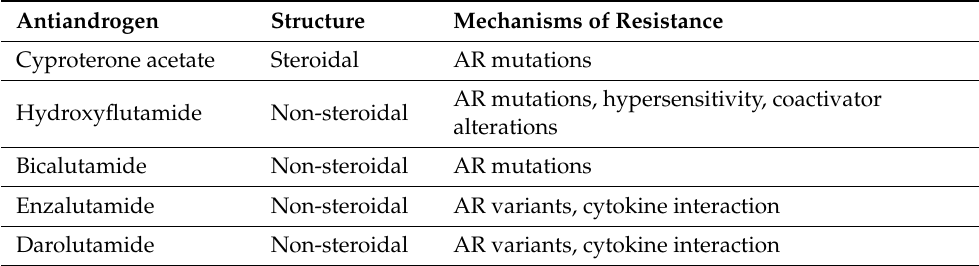
Table 1. Frequently used anti-androgens in prostate cancer therapy in the past and